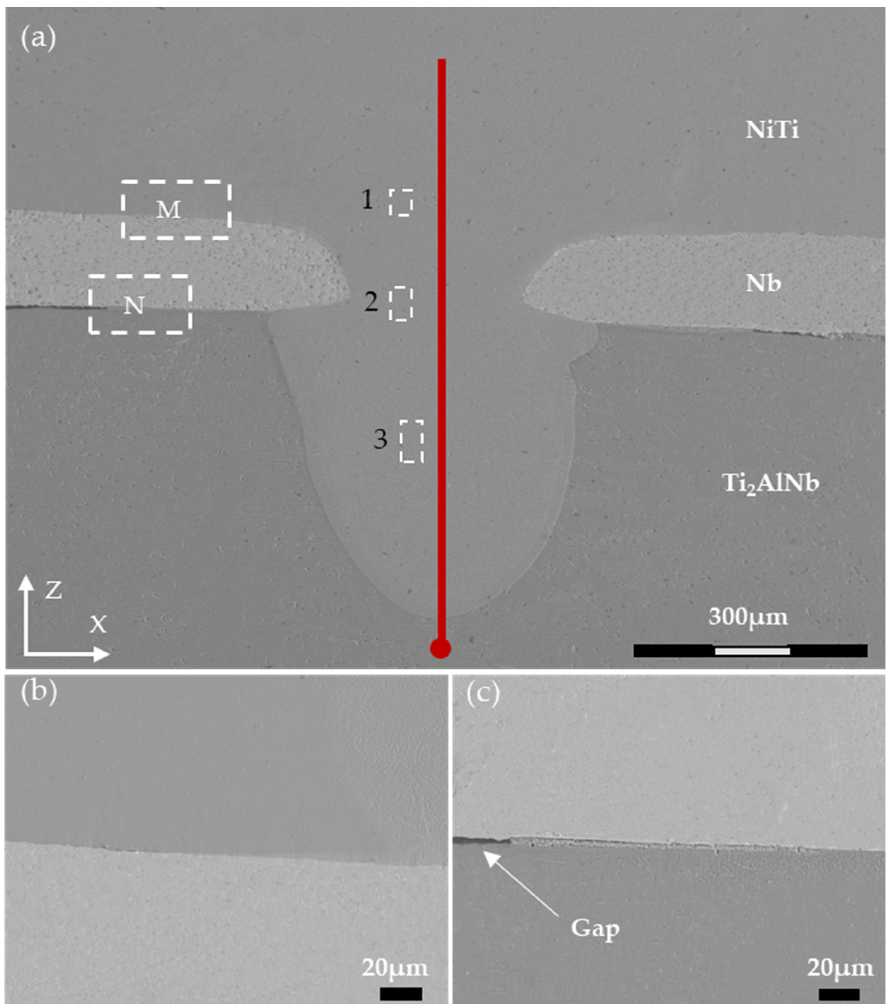
Figure 5. SEM images of: ( a ) Interface between NiTi, Nb and Ti 2 AlNb;( b ) Zone M of Figure 5a; ( c ) Zone N of Figure 5a. (The red line represents the EDS line analysis.) (No. 3 sample).